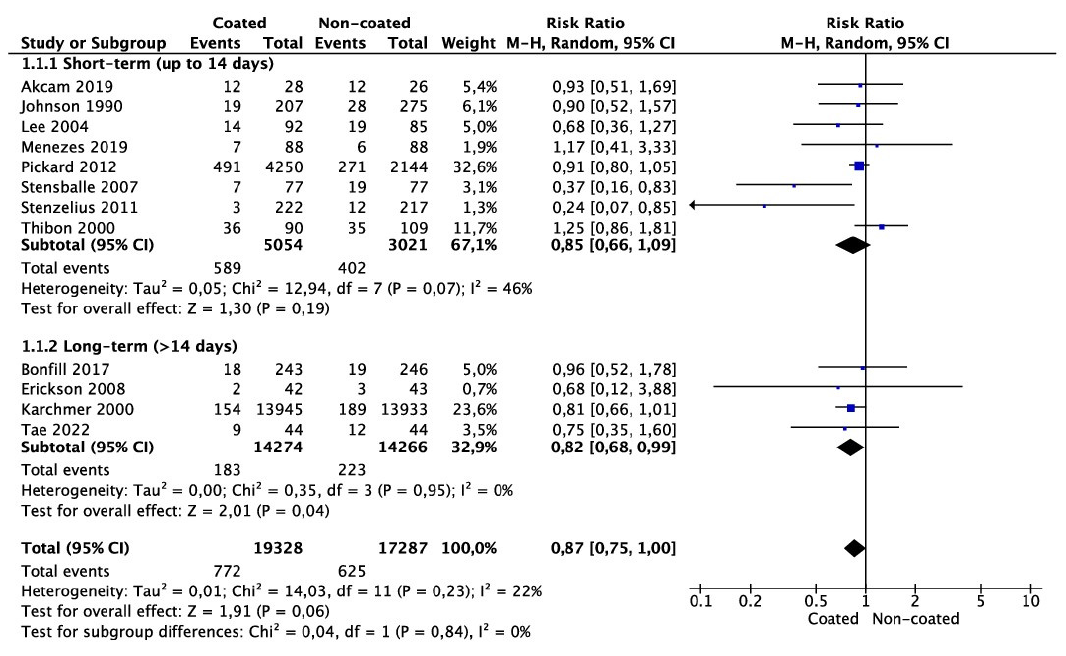
Figure 3. Meta-analysis of CAUTI incidence.